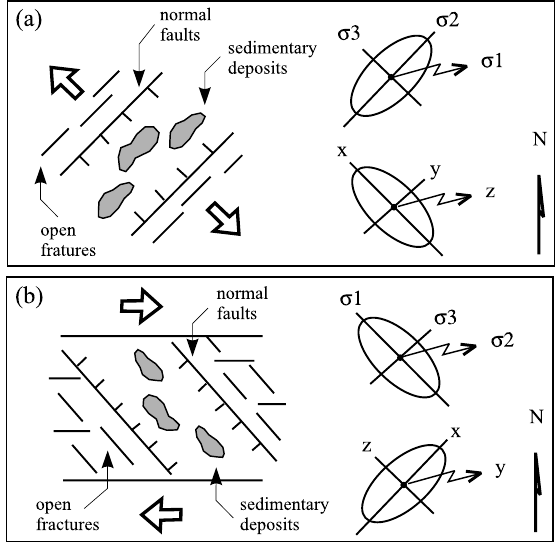
Fig. 3 – Regional tectonic movements with the principal structures that arisen out and the tension and deformation ellipsoids of (a) the exten- sional regime, that acted from Upper Cretaceous up to the Paleogene and (b) the dextral transcurrent regime, initiated on